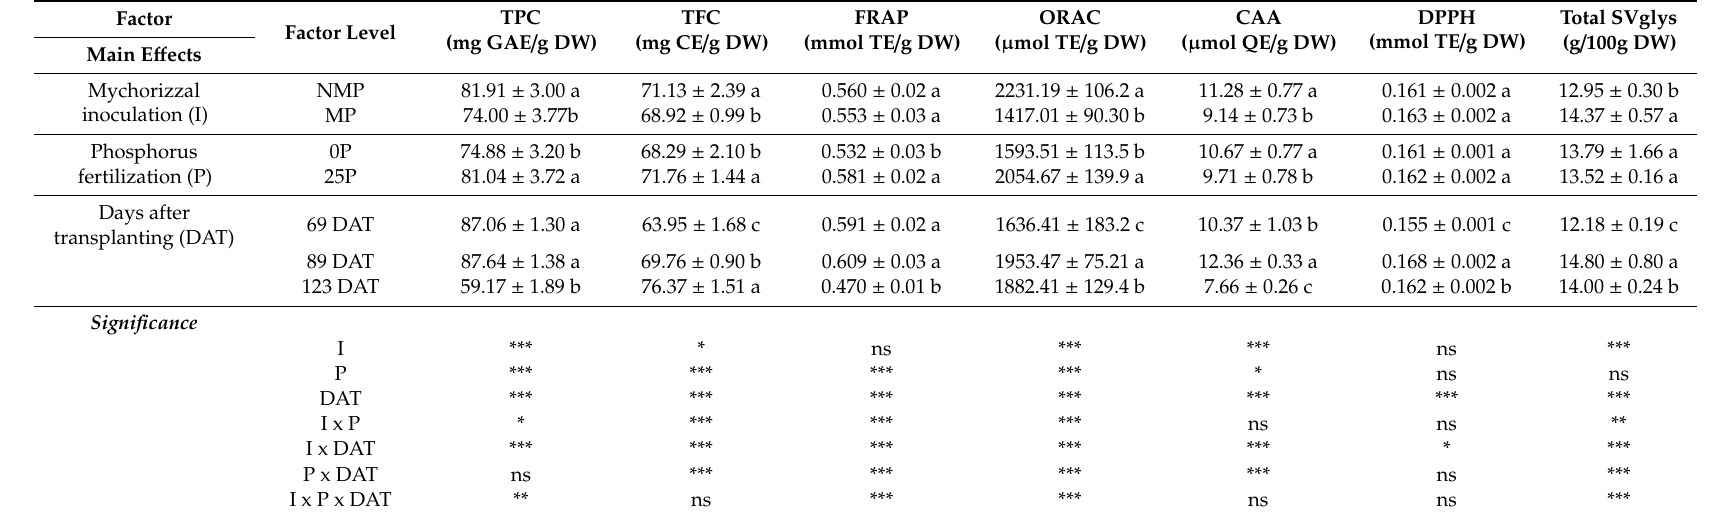
Table 1. Results of three-factorial analysis of variance (ANOVA) for secondary metabolites (total phenols, flavonoids and steviol glycosides) and antioxidant activities of stevia leaf